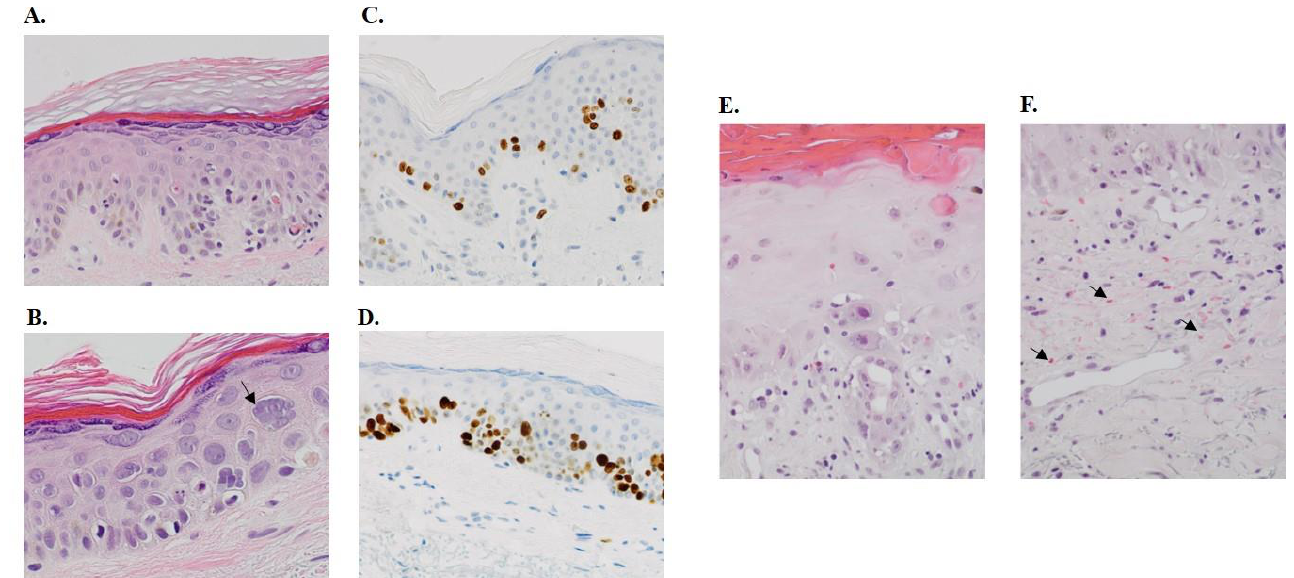
Figure 2. Histopathological changes in the skin. ( A ) This shows a skin biopsy of a patient after treatment with CPC634 with epidermis demonstrating hypergranulosis, influx of lymphocytes, basal vacuolisation of keratinocytes and scattered apoptotic cells along the dermo-epidermal junction (20x magnification). ( B ) This section is a 40× magnification of the same patient showing keratinocyte micronucleation (“grape cells”, arrow), also notice the accompanying apoptosis. Immunohistochemical stain for Ki67 at baseline ( C ) and after CPC634 treatment ( D ) (20× magnification). ( E ) This skin biopsy section of a patient in the Napoly study with skin toxicity shows an epidermis demonstrating vacuolar interface dermatitis with basal vacuolisation, influx of lymphocytes, scattered high apoptosis and hyper-and parakeratosis (20× magnification). Note the keratinocyte atypia with polymorphic nuclei and prominent nucleoli. ( F ) This section of the same patient shows ectatic capillaries and postcapillary venules of the superfical vascular plexus, a minor lymphohistiocytic perivascular infiltrate and extensive erytrocyte extravasation (arrow) (20× magnification).